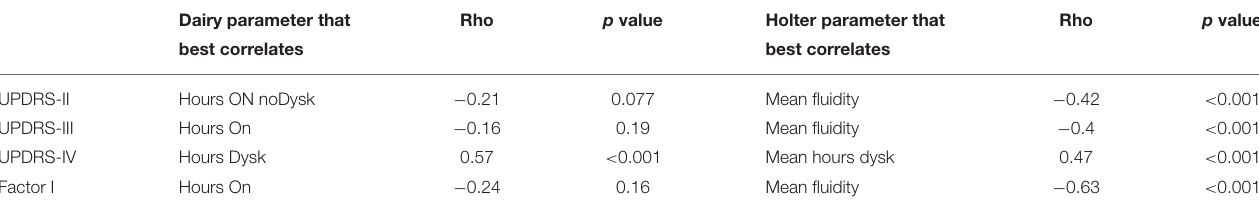
Dairy parameter that Rho p